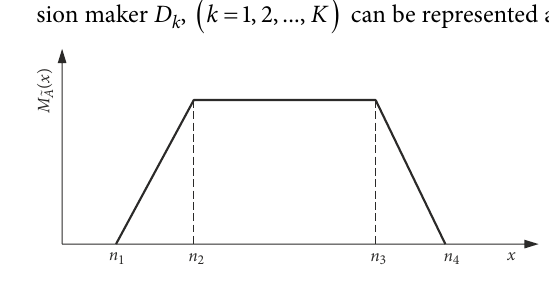
Figure 1. Trapezoidal fuzzy